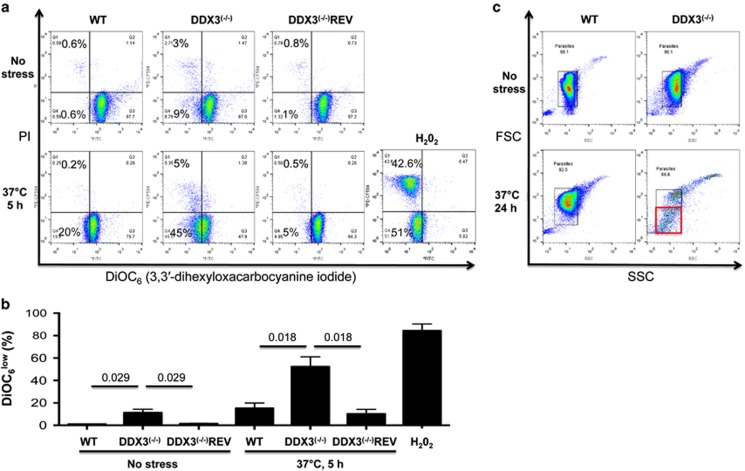
Heat stress induces mitochondrial membrane potential loss in Leishmania lacking DDX3. (a) 106 parasites from WT, DDX3(−/−), and DDX3(−/−)REV strains grown in RPMI medium were exposed or not to heat stress, double-stained with DiOC6(3) and propidium iodide (PI), and analyzed by flow cytometry to measure Δψm loss and membrane permeability and cell death, respectively. H2O2 treatment was used as a control inducing mitochondrial depolarization and death in ~50% of WT parasites after 8 h. (b) The results are means+S.E.M. of three independent experiments with duplicates and statistical significance was assessed using paired Student's t-test Prism version 6.0 (GraphPad Software, San Diego, CA, USA). The numbers over the lines correspond to P-values. (c) Cell morphology was assessed by flow cytometry on FSC and SSC parameters. WT and DDX3(−/−) parasites were cultured either at room temperature or at 37 °C for 24 h. After O/N exposure to heat stress, most of the DDX3(−/−) parasites demonstrated shrinkage (red square) and cell death